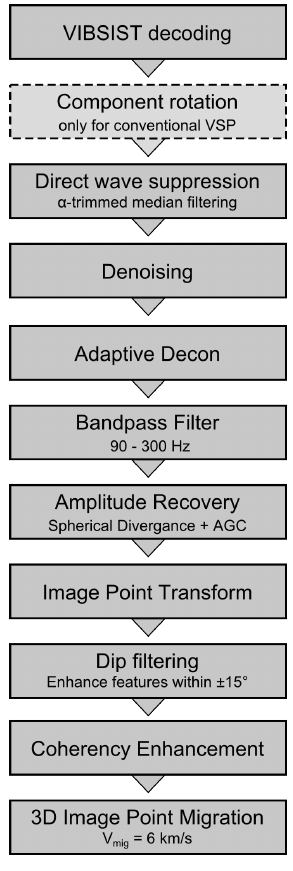
Figure 4. Processing flow applied to geophone VSP and DAS VSP data. Component rotation was only applied to geophone VSP data. Dip filtering and coherency enhancement were carried out in the Image Point (IP) space